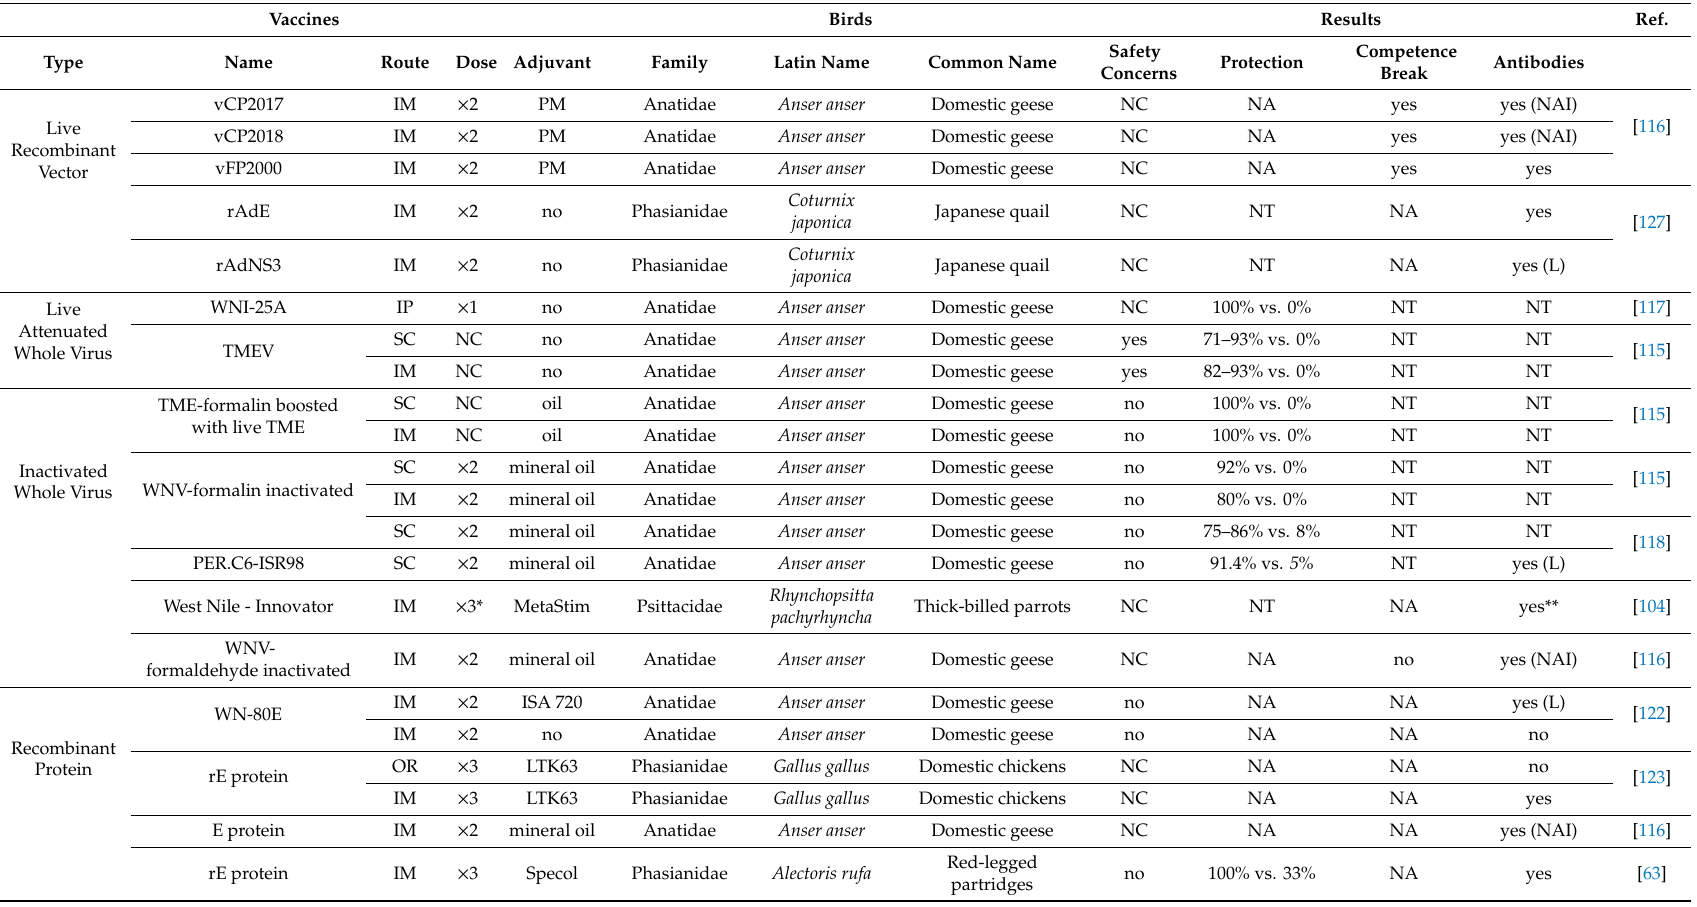
Table 2. Vaccines tested in domestic